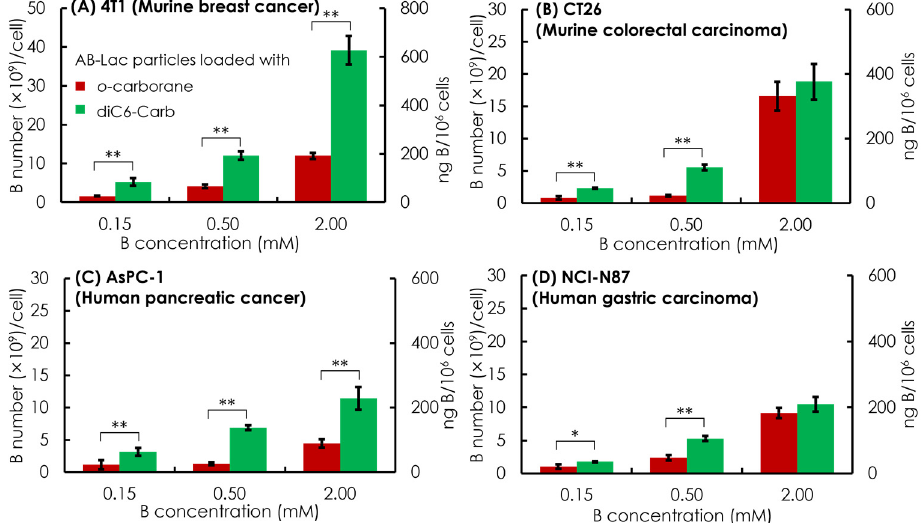
Figure 5. In vitro cell uptake of the AB-Lac particles loaded with o- carborane or diC6-Carb in dif- ferent cancer cells, 4T1 ( A ), CT26 ( B ), AsPC-1 ( C ), and NCI-N87 ( D ). Data are expressed as mean ± S.E.M. ( n = 3). Significant differences are represented by ** p < 0.05 and * p <